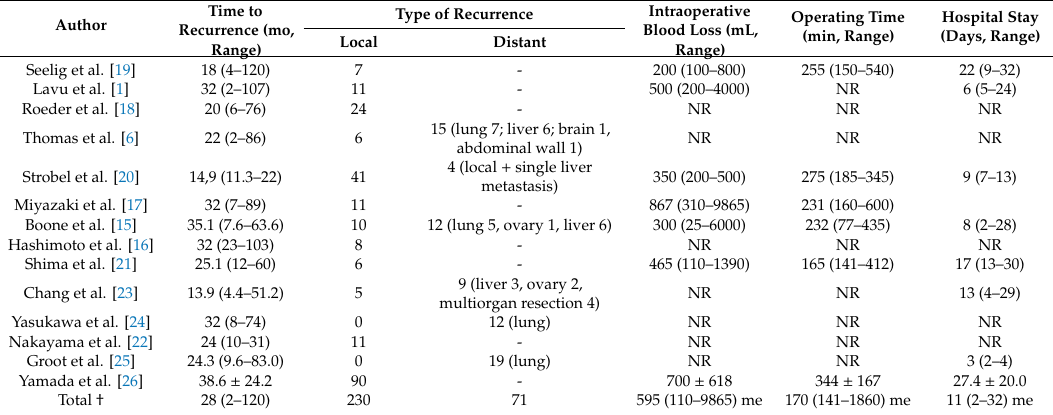
Table 2. Characteristics of pancreatic ductal adenocarcinoma (PDAC)